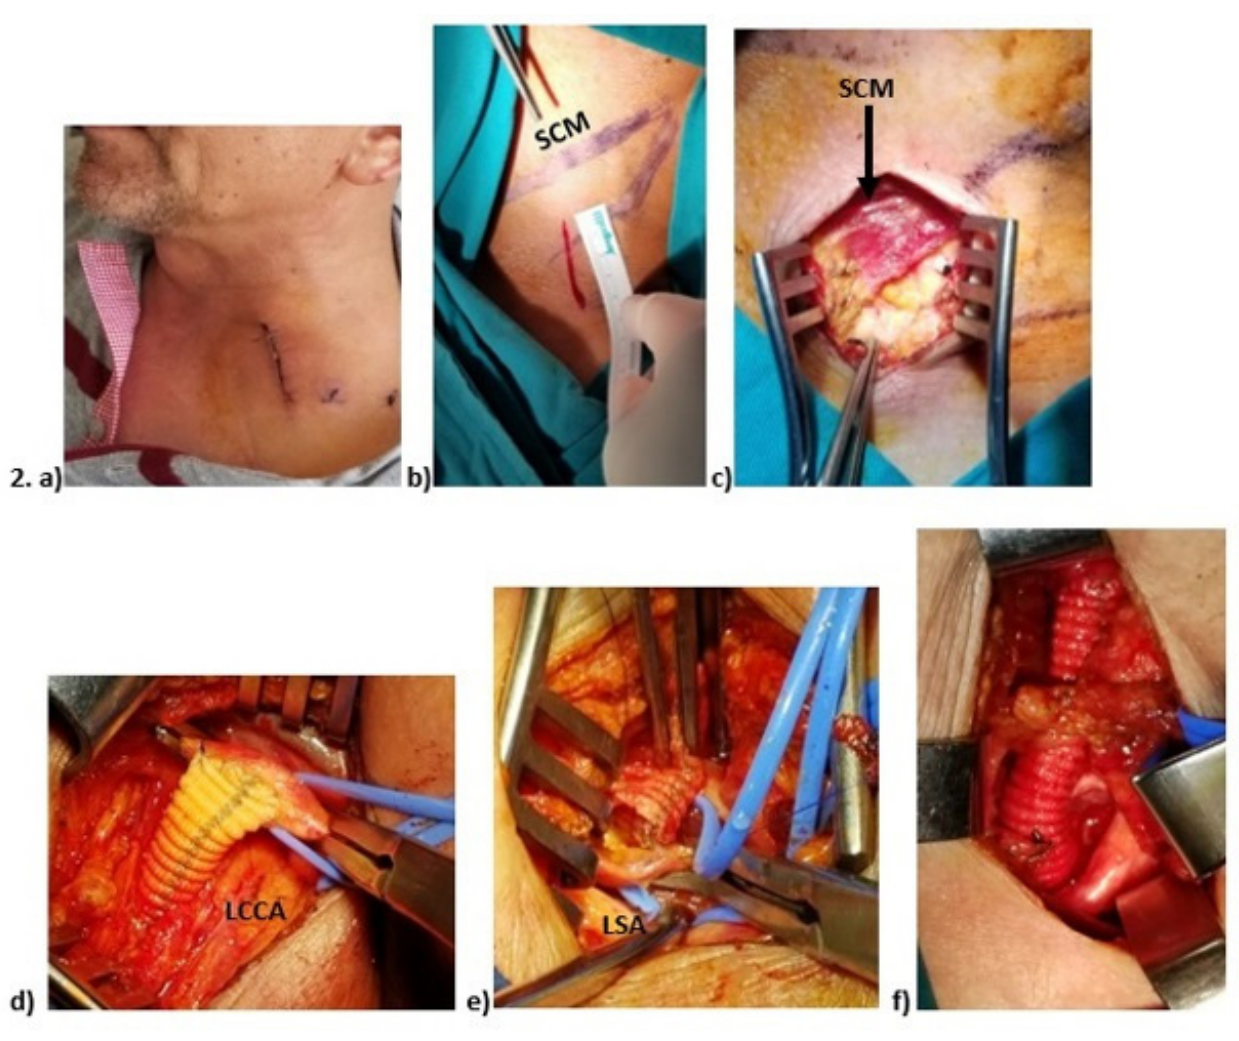
Fig. 1 – (A) A 3 to 4-cm-long skin incision was made in the supraclavicular region. (B, C) The sternocleidomastoid muscle was mapped on the skin and exposed. (D) Proximal anastomosis of the graft to the left common carotid artery. (E) Distal anastomosis of the graft to the left subclavian artery. (F) The bypass graft passing through the tunnel in the scalene fat pad. LCCA: left common carotid artery; LSA: left subclavian artery; SCM: sternocleidomastoid.